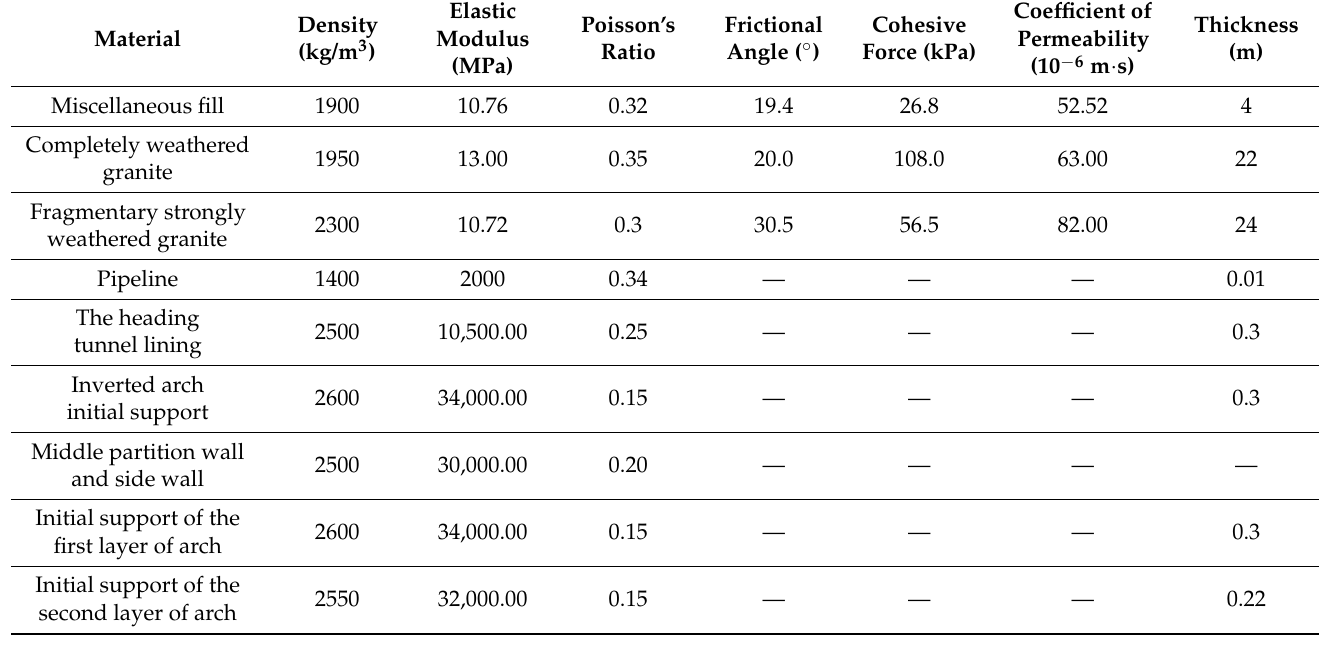
Table 3. Model material parameters.